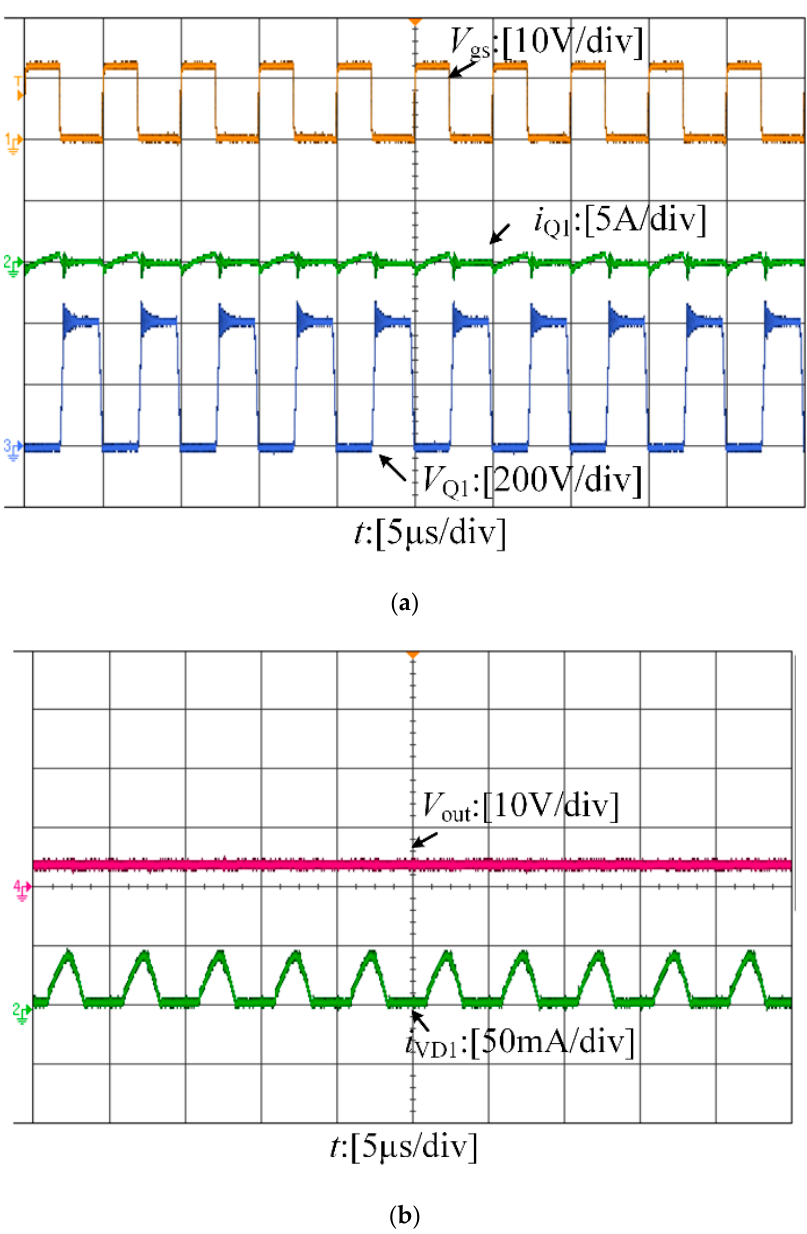
Figure 17. Experimental waveforms at RZP. ( a ) Waveforms of Q 1 . ( b ) Waveforms of VD 1 and output voltage, V out .